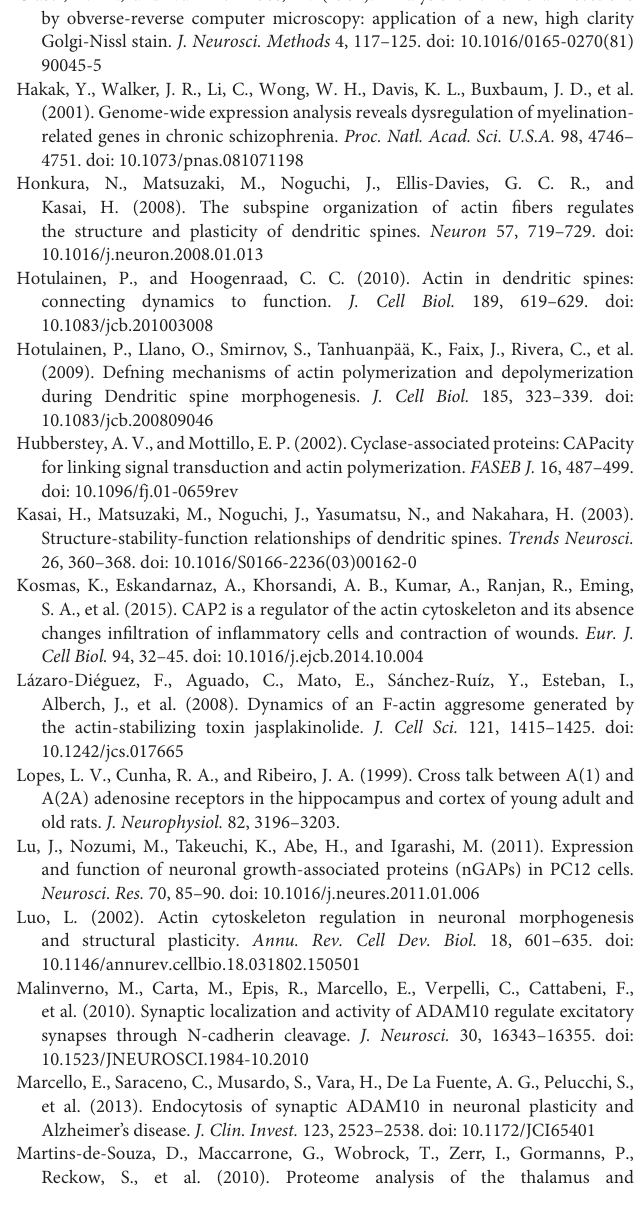
with pEGFP-C2 showed an increased number of dendritic filopodia in mutant neurons at div 7 (WT: 0.3 ± 0.05 dendritic protrusions/ µ m, n = 30 neurons from 3 cultures; Cap2 gt / gt : 0.54 ± 0.04 dendritic protrusions/ µ m, n = 24 neurons from 3 cultures, p < 0.01). Scale bar, 5 µ m. (D) Representative image of second order dendritic shaft from hippocampal neurons visualized with Golgi-Cox staining. (E) Expression level of CAP1 in brain lysate was quantified after immunoblotting the WT and CAP2 mutant brain lysate with CAP1 polyclonal antibody (WT: 3.0 ± 1.0 AU, n = 5 mice; Cap2 gt / gt : 3.2 ± 1.1 AU, n = 6 mice, p > 0.05). AU, arbitrary unit. FIGURE S3 | Expression of kinases and phosphatases involved in Cofilin phosphorylation/dephosphorylation cycle. Western blotting of phospho LIMK1/LIMK2 and LIMK2 do not show any significant difference in WT and CAP2 mutant brain lysate. The levels of other kinases like TESK1 and ROCK1 were also unaltered in mutant brain lysate as was the level of